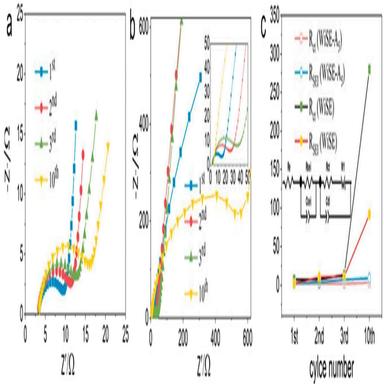
(a, c) Nyquist plots of full cells utilizing (a) WiSE-A5 and (b) WiSE electrolytes, captured after 1, 2, 3, and 10 cycles. (c) Presents the fitting results of charge transfer resistance (Rct) and solid electrolyte interphase resistance (RSEI) derived from EIS measurements. Reproduced with permission from Wiley.